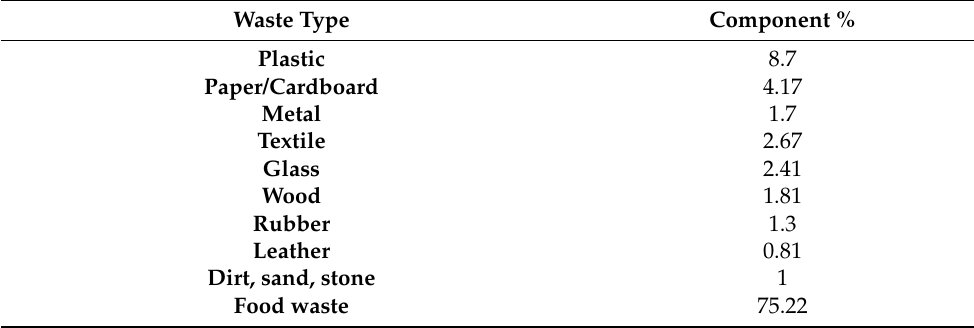
Table 12. Composition of the MSW in